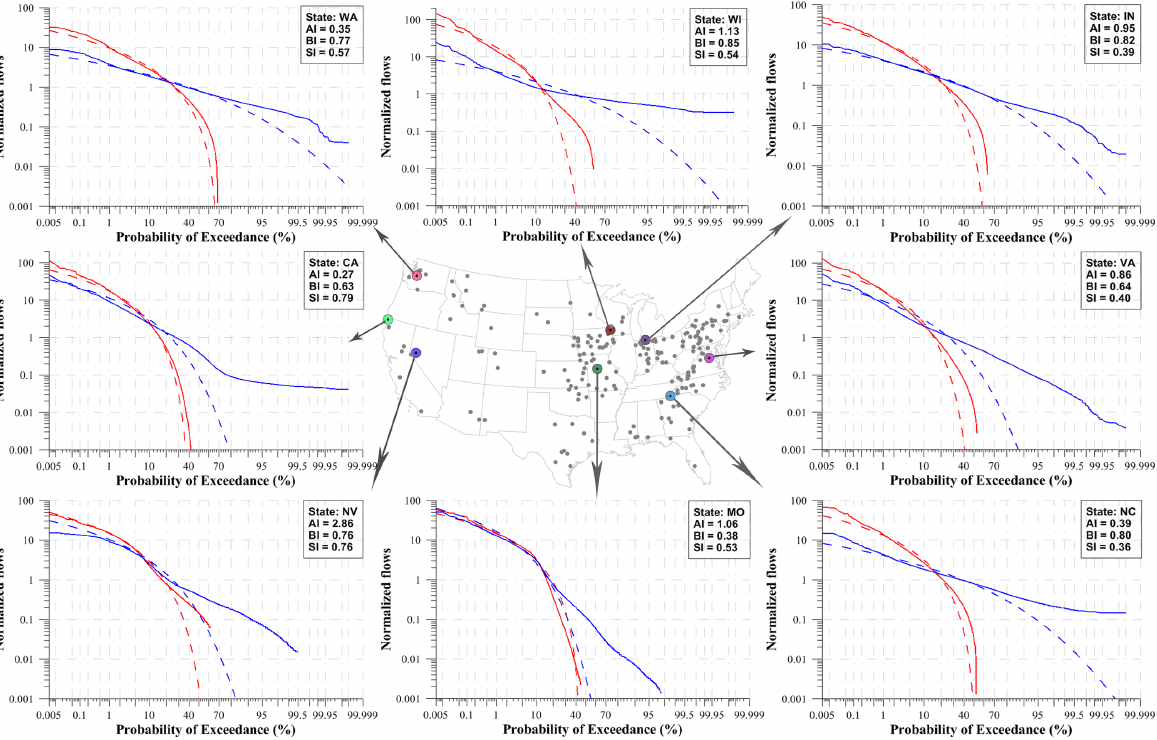
Fig. 3. Normalized empirical FDCs (solid lines) and gamma distribution fits (dash lines) for 8 catchments: TFDC (blue lines) and FFDC (red